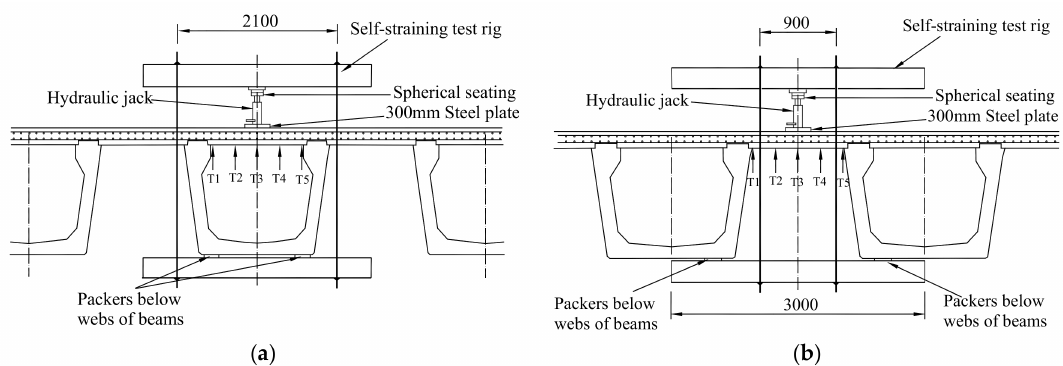
Figure 6. Test for the Thompson Bridge slab. ( a ) Test for the slab between the W-beams; ( b ) Test for the slab between W-beams and